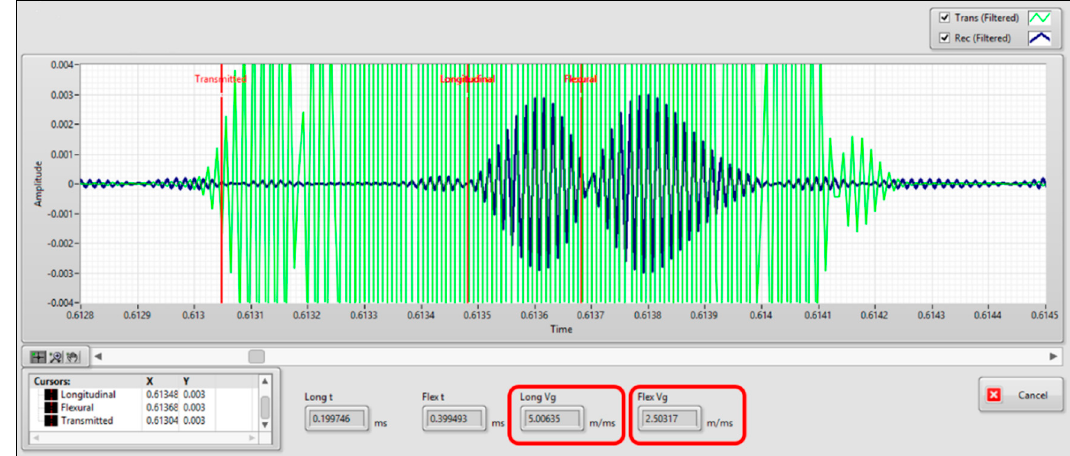
Figure 12. Guided wave propagation mode identification of a group of signals transmitted through 1 m of 1K22 MP-35N cable. The pale green curve shows the transmitted pulses and the dark green curve shows the excited guided waves modes.